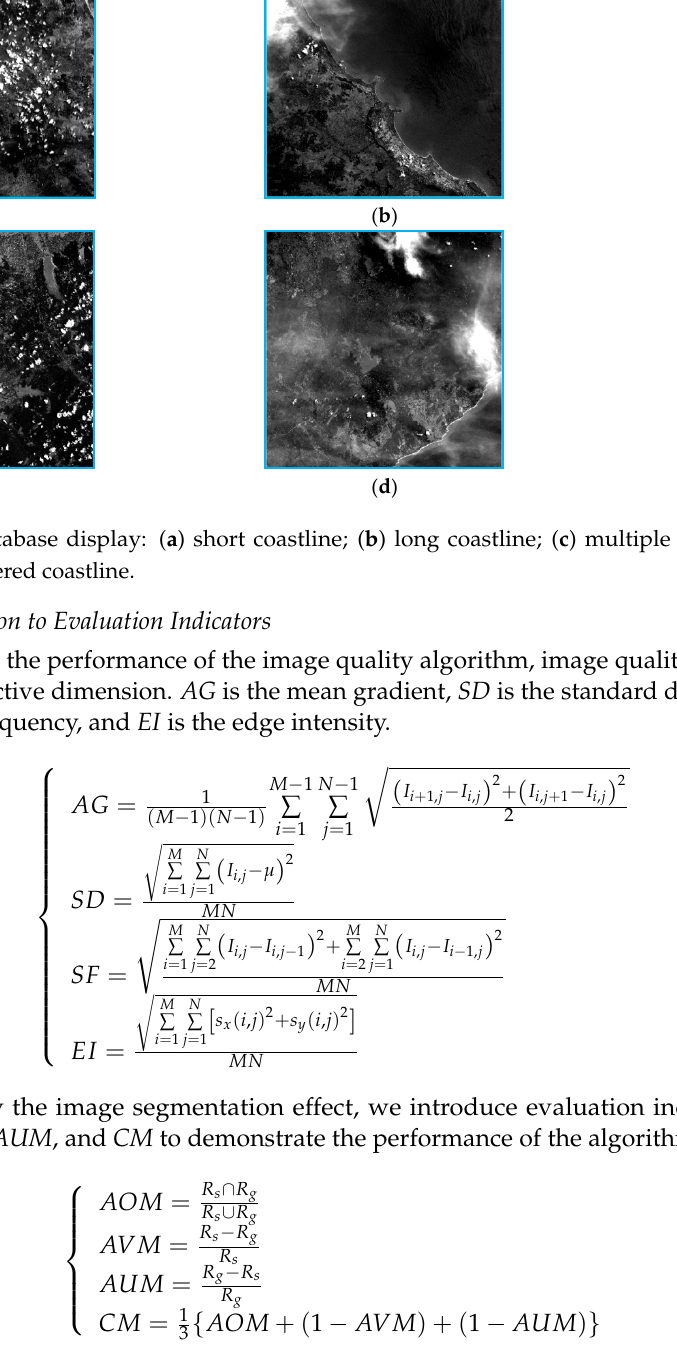
Figure 9. Map of Sri Lanka.